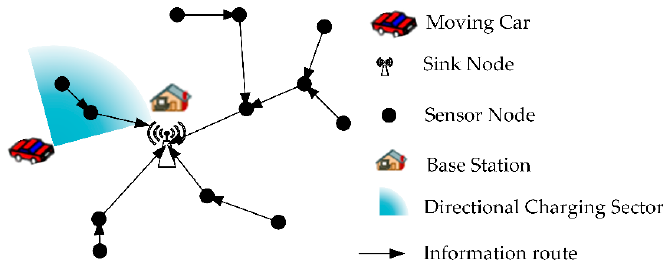
Figure 1. Directional mobile charging scenario for the data collection network in RWSN (Rechargeable Wireless Sensor Networks).